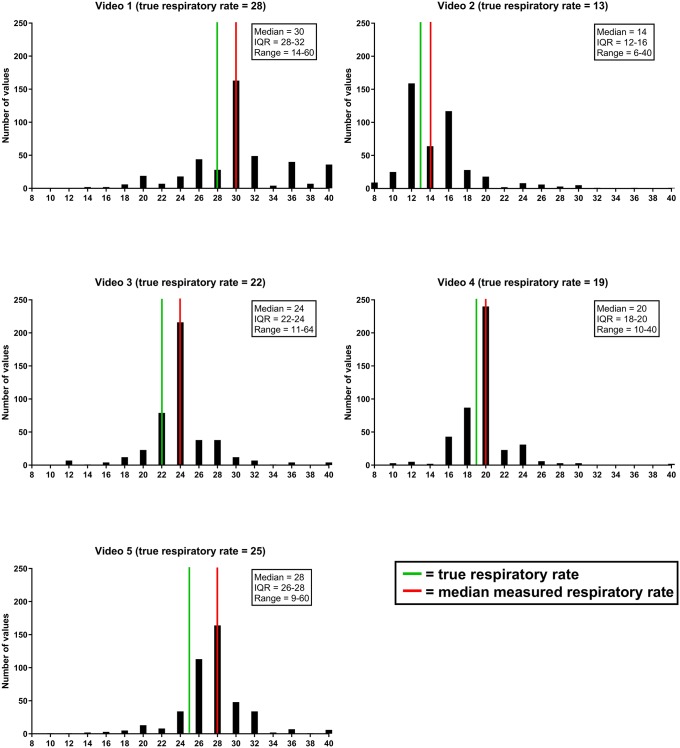
Measured respiratory rates for each video.* Extreme values (<8/>40) are not depicted in these graphs.